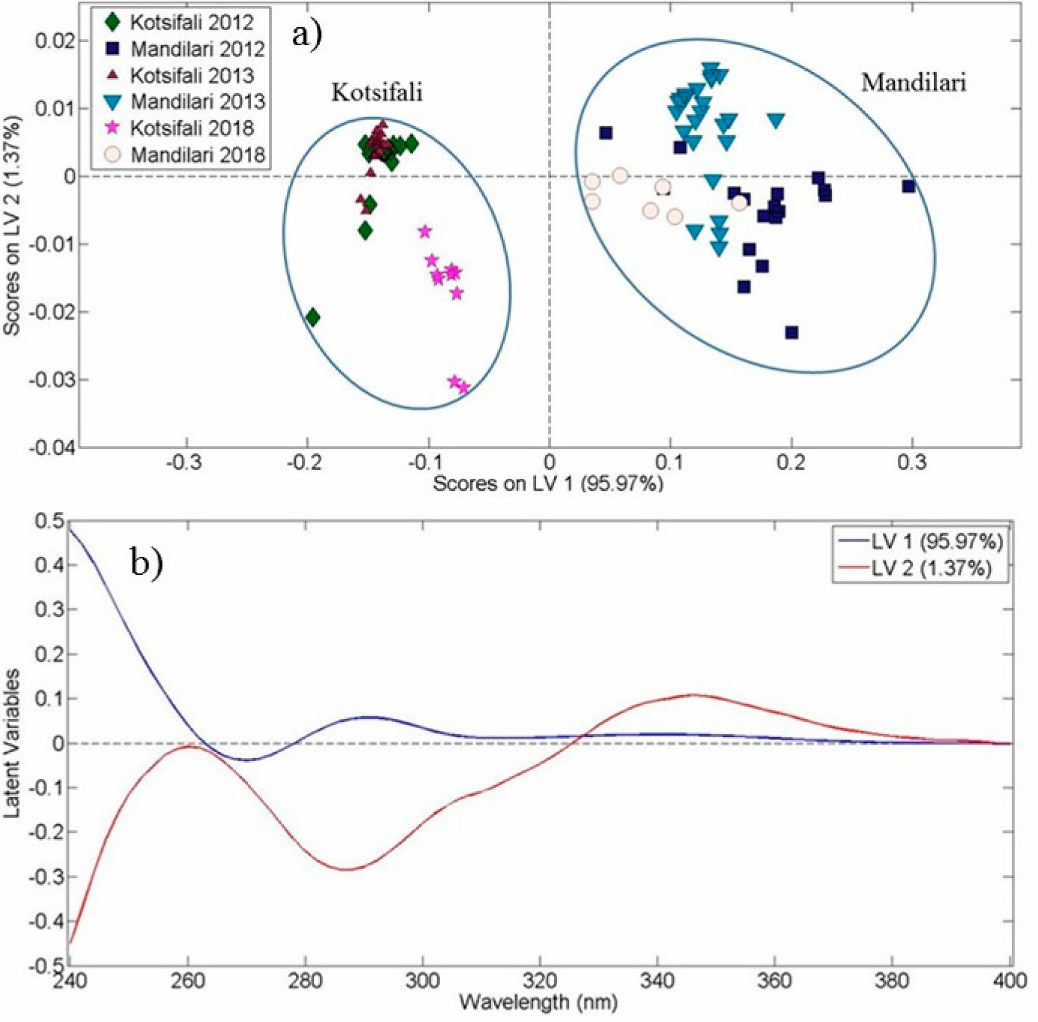
Figure 3. Red wine Kotsifali and Mandilari varieties discrimination. ( a ) Score plot of the first two latent variables resulting from the Orthogonal Partial Least Squares—Discriminant Analysis (OPLS-DA) application on ultraviolet spectral data of 101 red wine samples (2012, 2013 and 2018 vintages), and ( b ) The corresponding loading plot. Latent variable 1 is designated by the blue line and latent variable 2 by the red